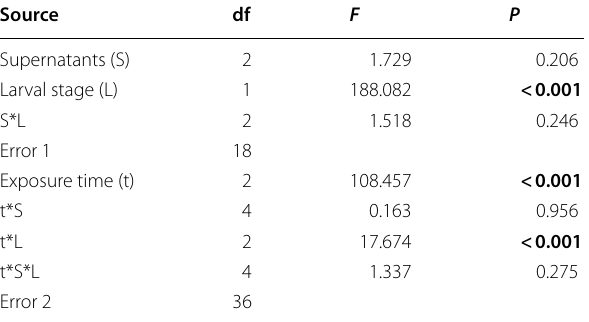
Table 7 The oral effect of supernatants of symbiotic bacteria of different entomopathogenic on the mortality (%) of different larval instars of Agrotis segetum for 1, 2 and 3-day